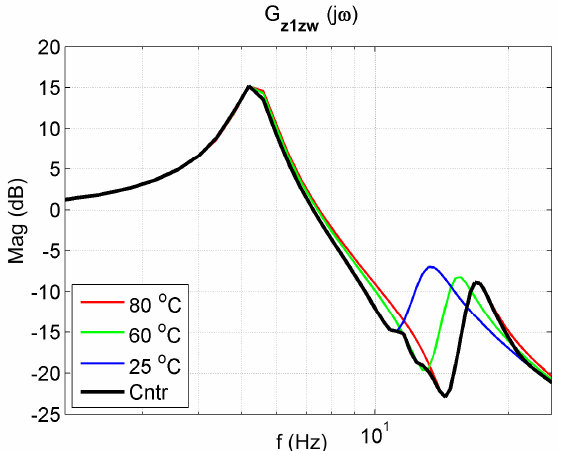
Figure 19. Vibration transmissibility functions of disturbance z w to the protected mass m 1 of the passive absorber for selected temperatures of 25 ◦ C, 60 ◦ C, 80 ◦ C and the controlled absorber (black). The transfer function G z 1 zw describes the object.